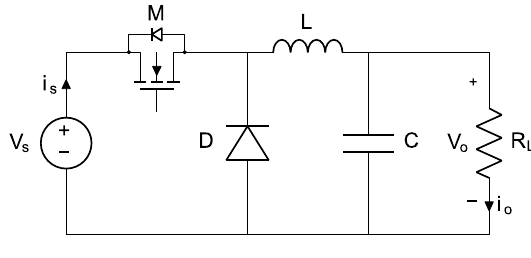
Figure 3. Buck converter circuit.